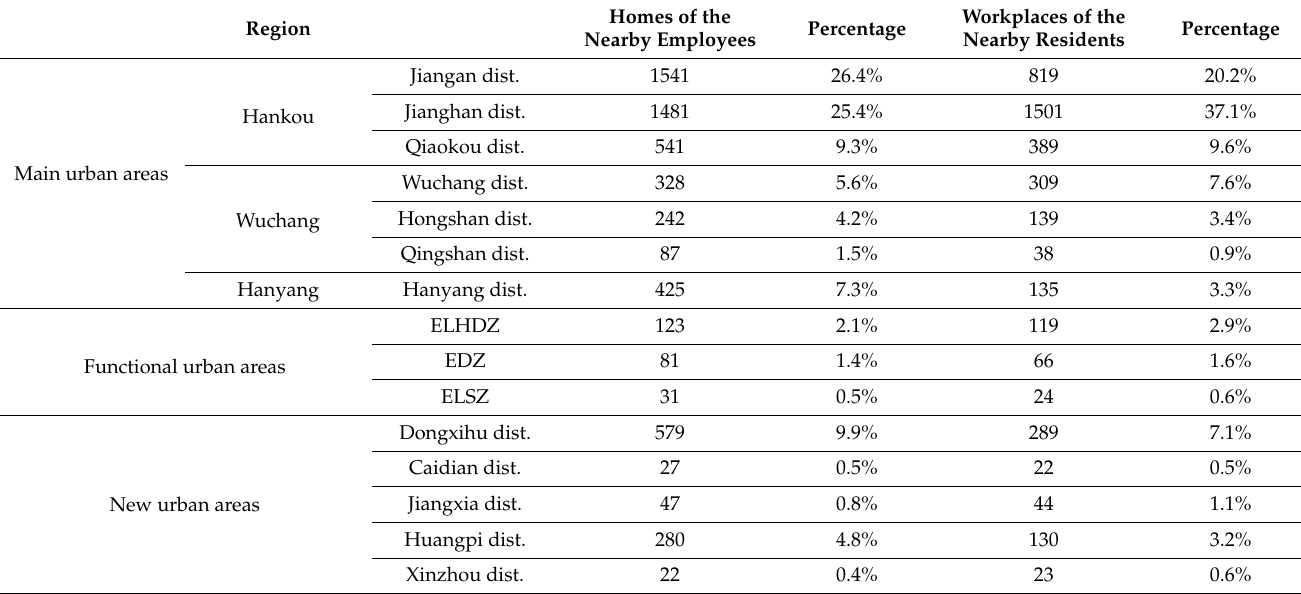
Table 3. Origins and destinations of the commuters nearby the market. Region